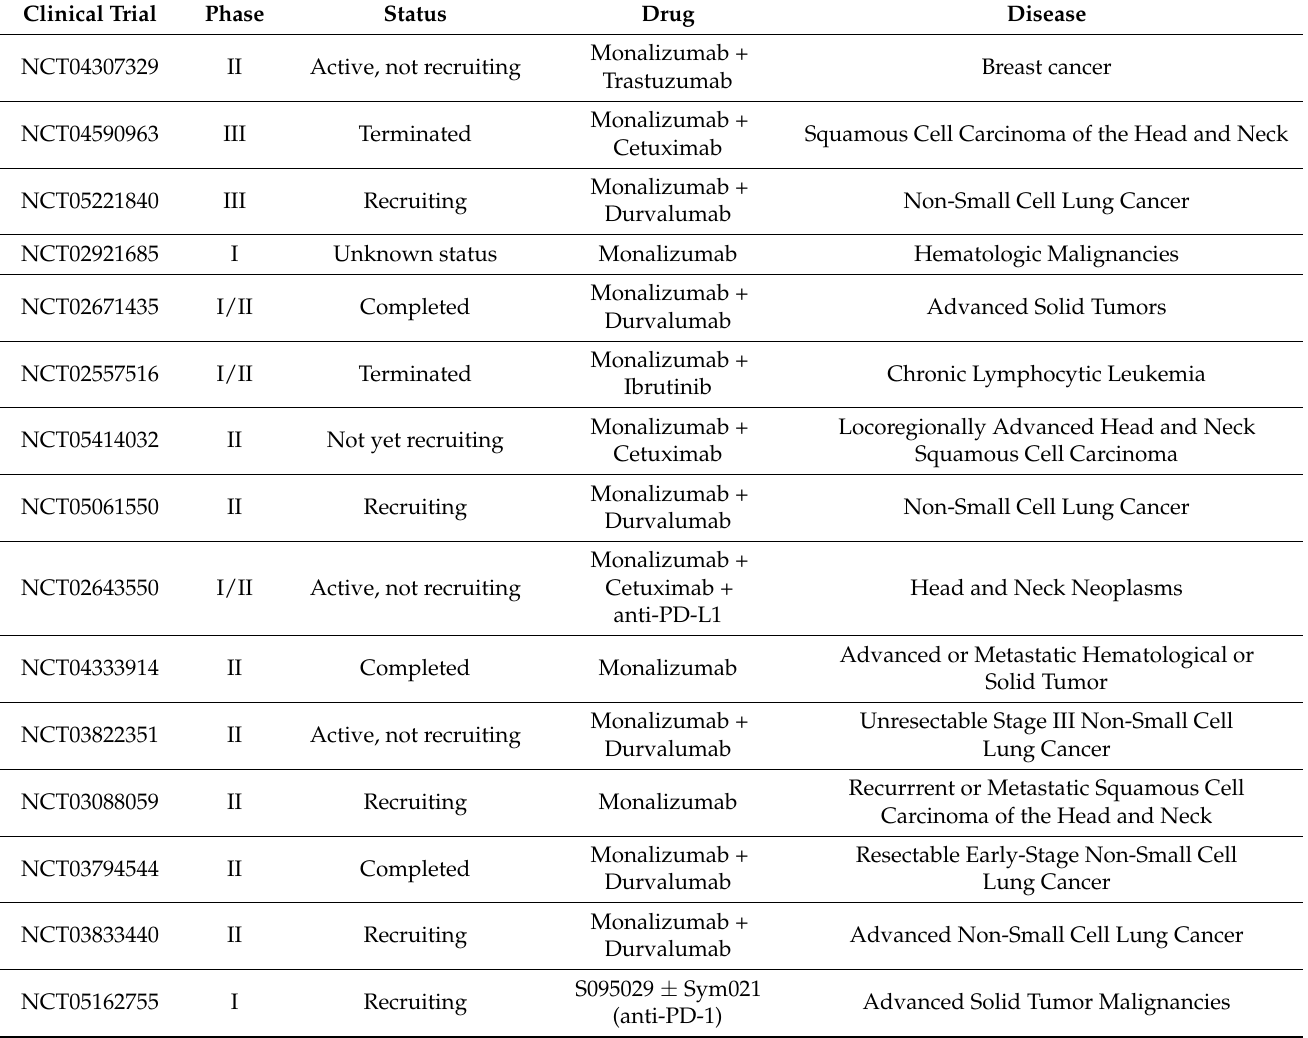
Table 2. Clinical trials with anti-NKG2A mAbs for the treatment of